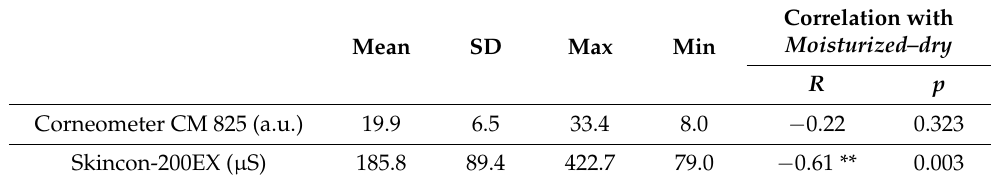
Mean SD Max Min